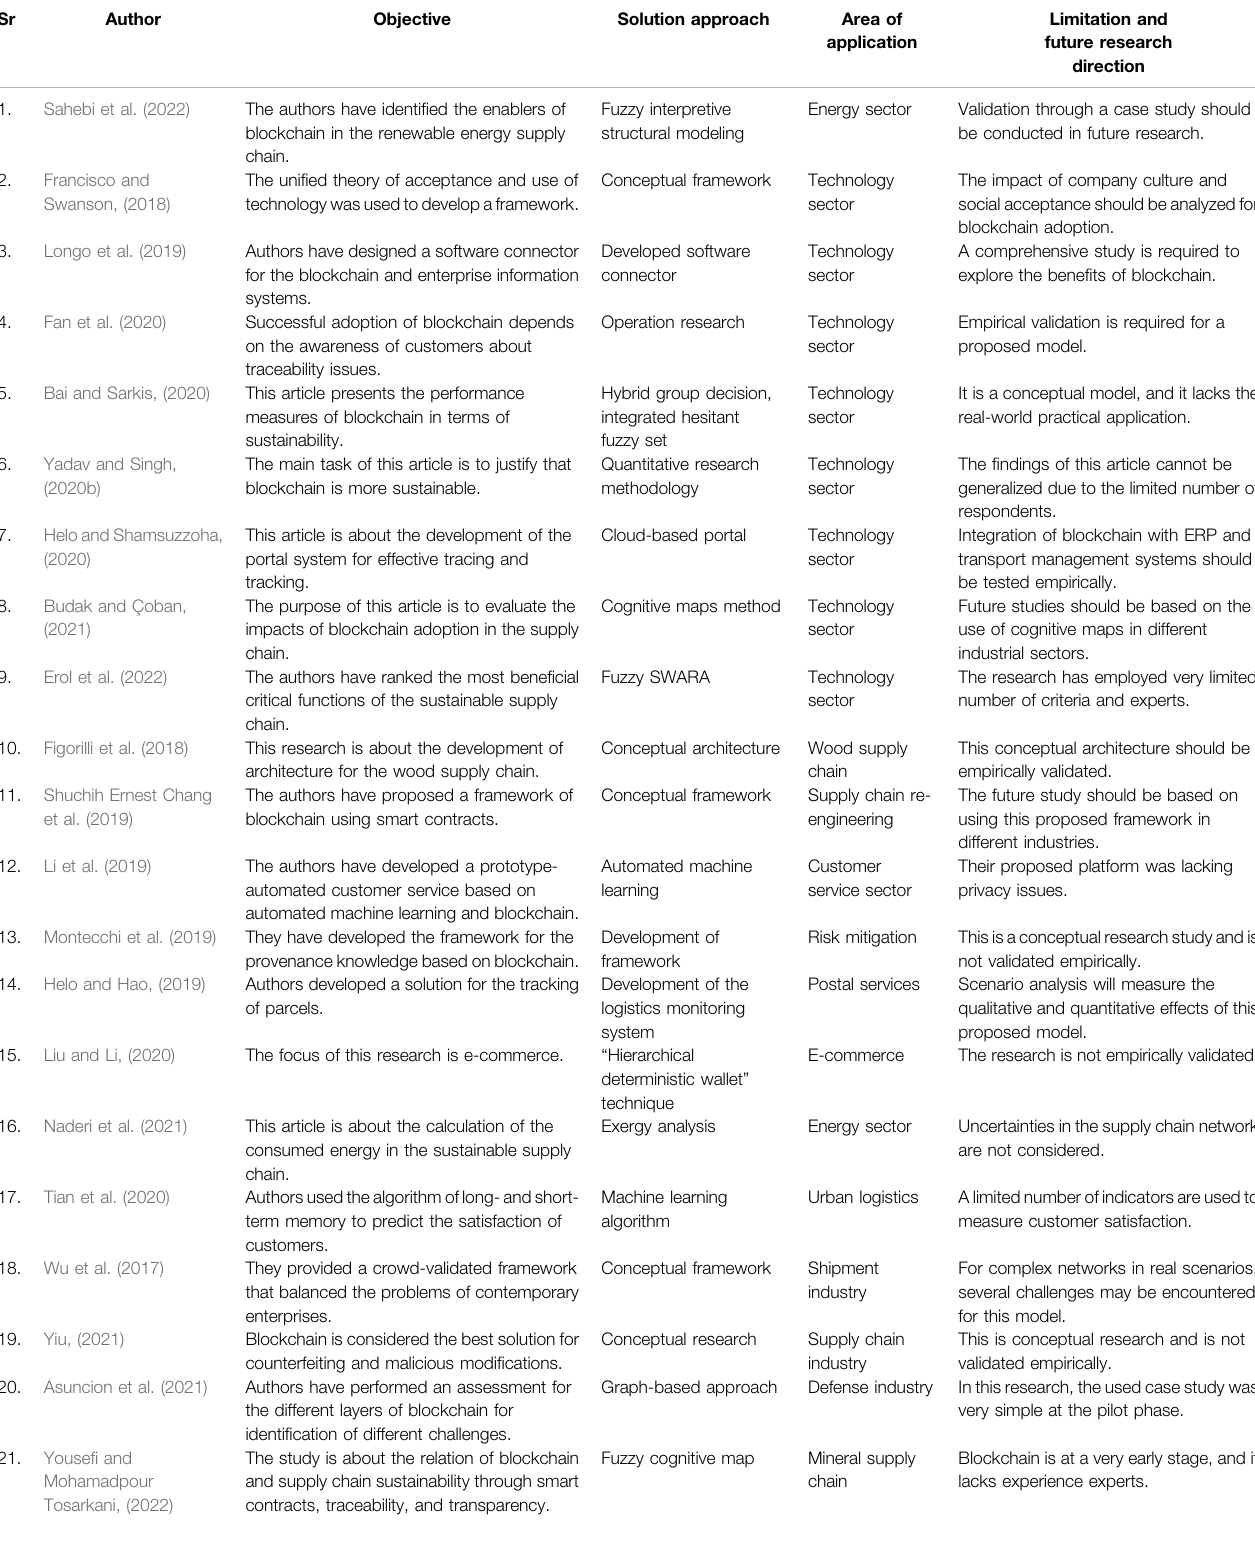
TABLE 2 | Models and framework development for the blockchain-based supply chain and economic sustainability for different